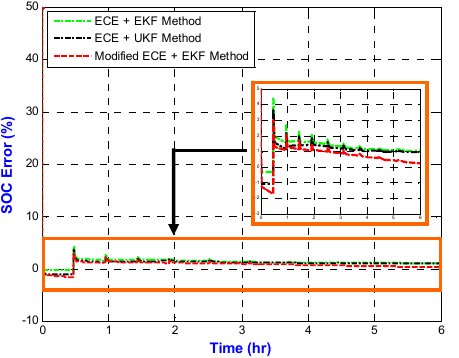
Figure 17. SOC estimation error under charge in Experiment II.